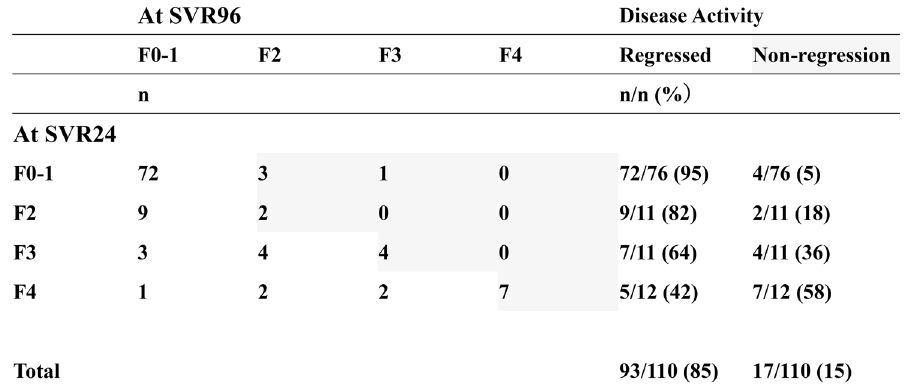
Figure 2. Changes in liver fibrosis stage based on LSM between SVR24 and SVR96 in HCV-infected patients treated with DAAs. LSM liver stiffness measurement, SVR sustained virological response, DAAs direct-acting antivirals. The grey area represents the regression of liver fibrosis after DAA